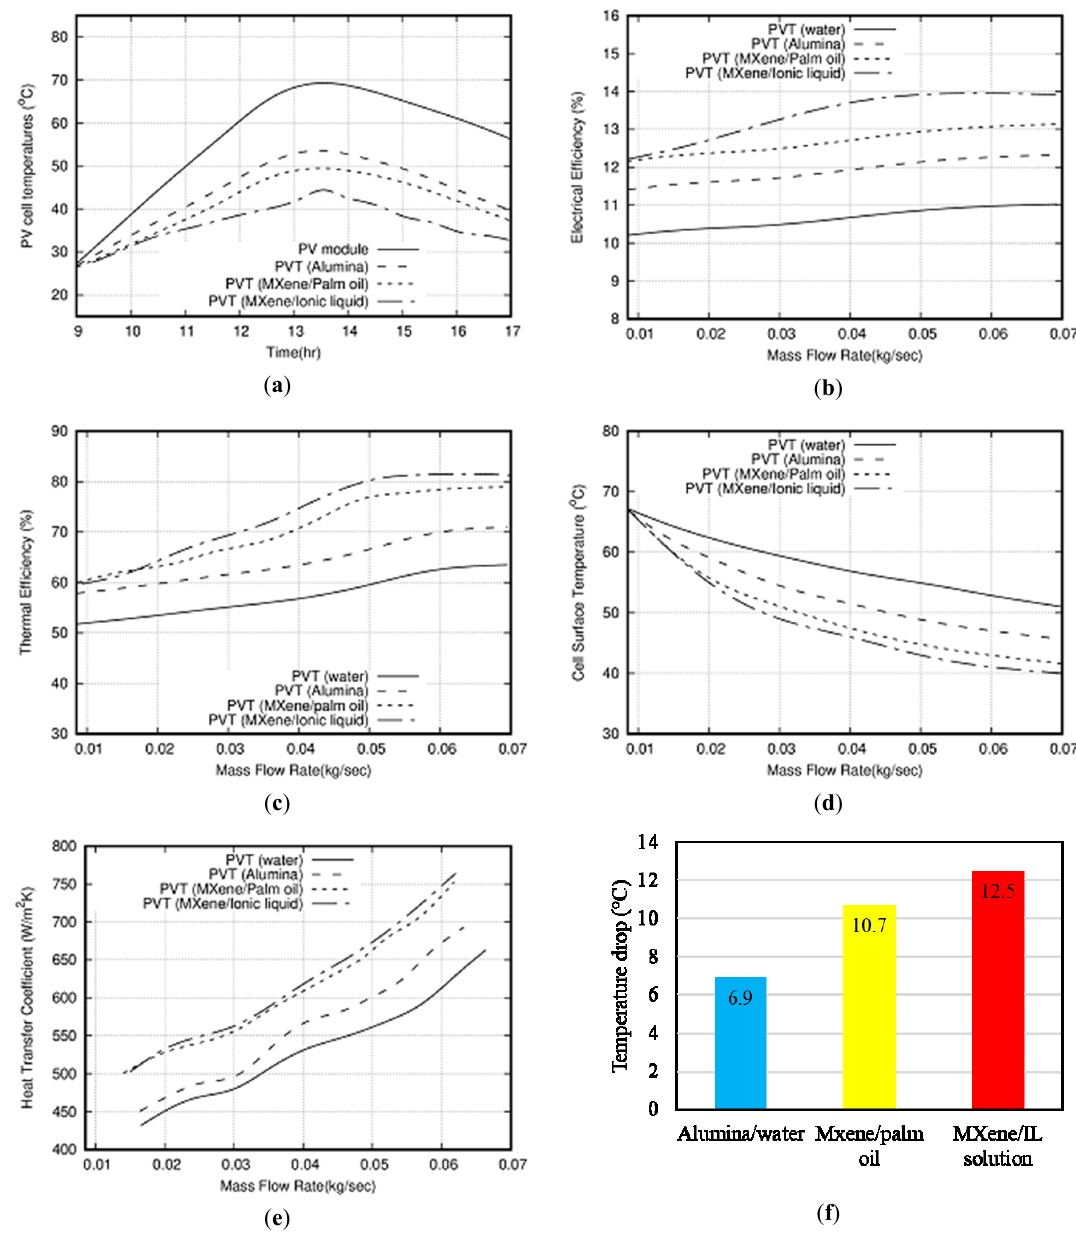
Figure 14. ( a ) Variation of PV panel temperature with time during a day for different types of coolant. ( b ) Electrical efficiency of PV/T system as a function of mass flow rate with different types of coolant. ( c ) Thermal efficiency of PV/T system as a function of mass flow rate with different types of coolant. ( d ) PV panel temperature as a function of mass flow rate using different types of coolant. ( e ) PV/T system heat transfer coefficient variation with mass flow rate using different types of coolant. ( f ) Drop in PV panel temperature by using different nanofluid types in comparison to a water-cooled system.